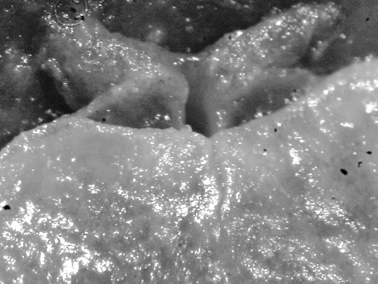
Phyllidiella striata, 35 mm (NY-202), view of propodium, head, and oral tentacles.